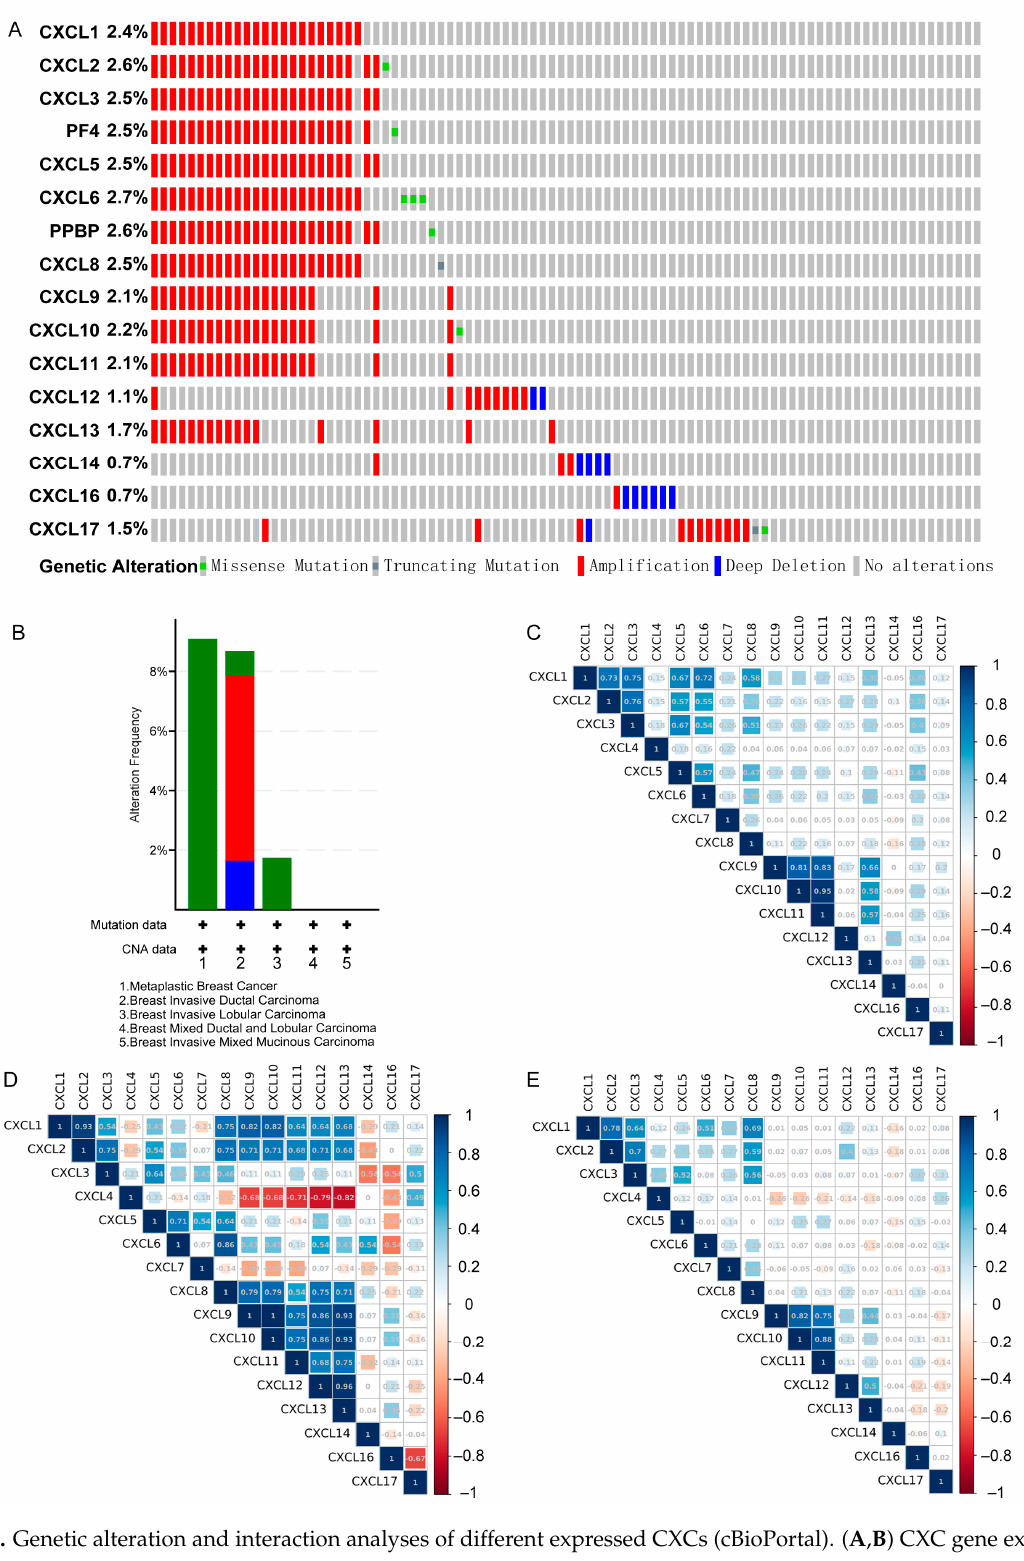
Figure 13. Genetic alteration and interaction analyses of different expressed CXCs (cBioPortal). ( A , B ) CXC gene expression and mutation analysis in breast cancer. ( C ) Correlation heat map of different expressed CXCs in BRCA. ( D ) Heat map of different expressed CXCs correlations in COAD. ( E ) Correlation heat map of different expressed CXCs in PDAC.